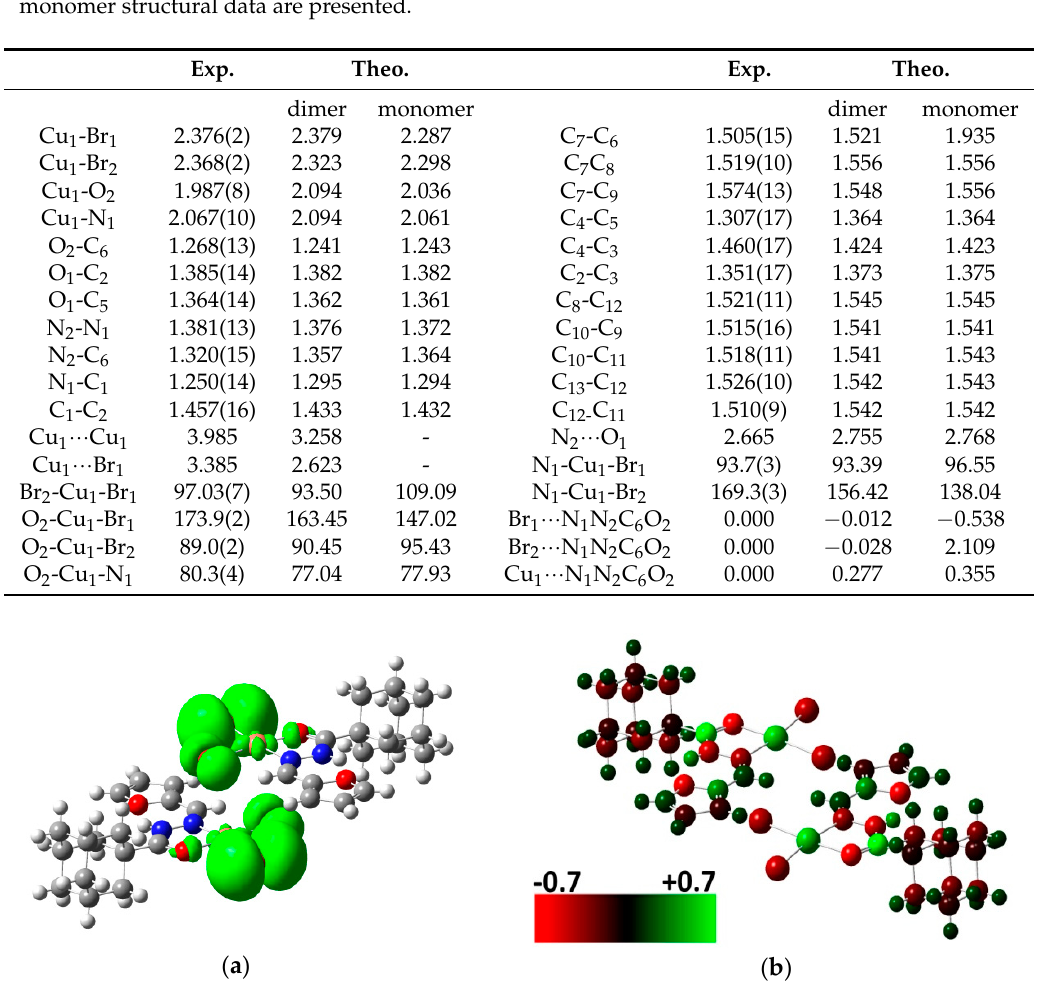
Table 2. Selected bond distances (Å) and bond angles ( ◦ ) for 1 . Experimental, optimized dimer and monomer structural data are presented.